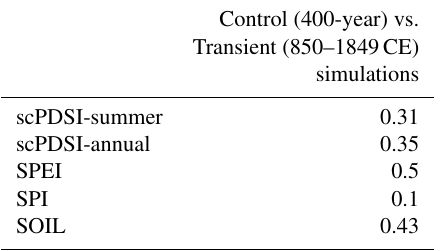
Table A1. P values from the Mann–Whitney U tests between the drought indices in the control and transient simulations.